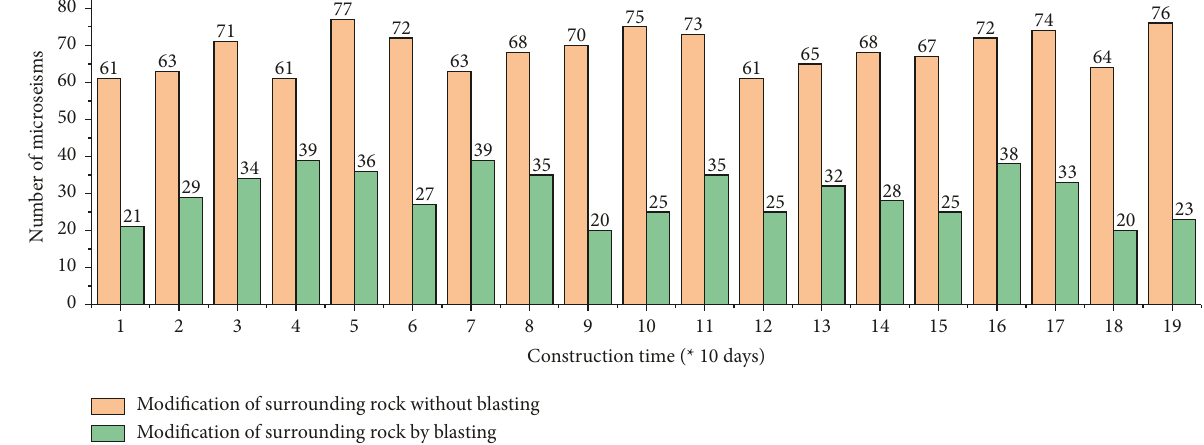
Figure 11: Change of microseismic quantity after blasting loosening modification of surrounding rock.